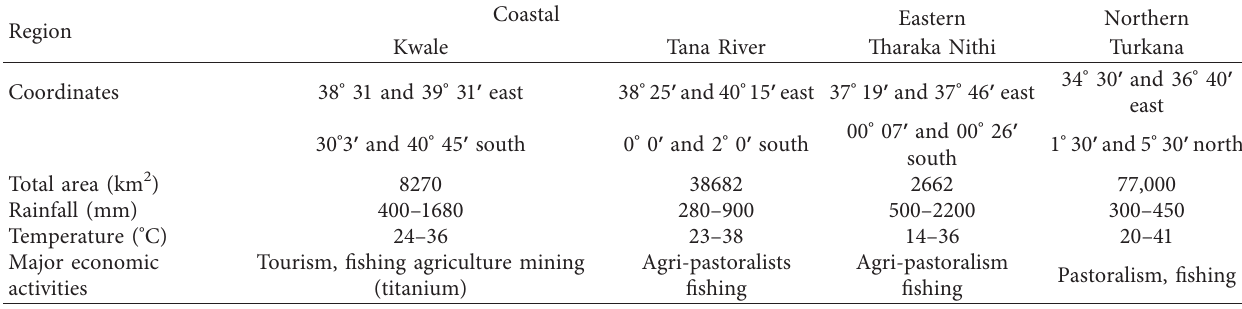
Table 1: Attributes of the study sites from which Hyphaene compressa (doum palm) samples were collected in Kenya in 2018.